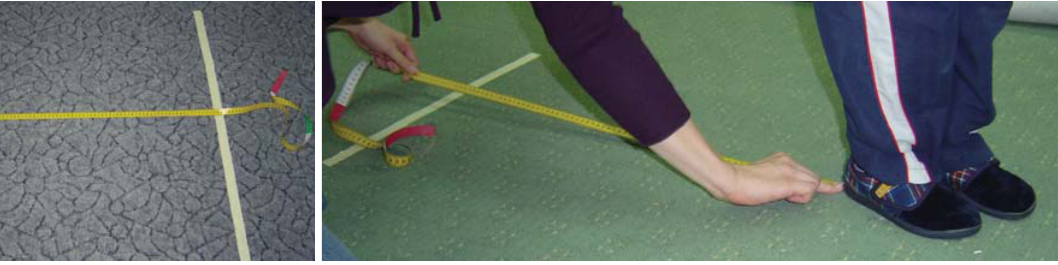
Figure 3. Force test (cm) — standing long jumping